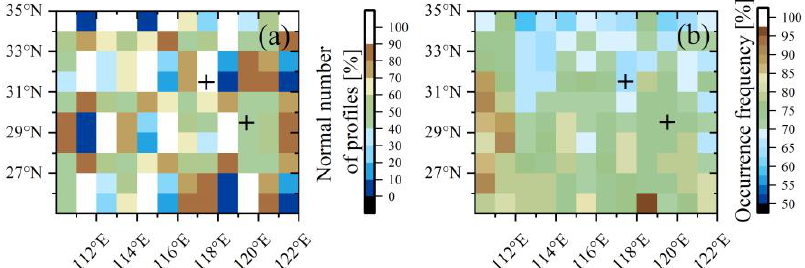
Figure 4. ( a ) Normal number of profiles per grid box. The maximal amount of profiles is 15237; ( b ) The geographical distribution of cloud occurrence frequency; the cross symbols correspond to the lidar sites.